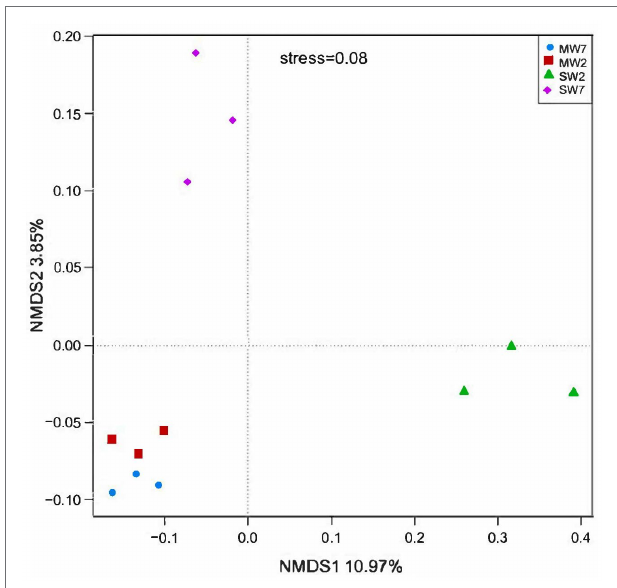
FIGURE 1 | The non-metric multidimensional scaling (NMDS) analysis of bacterial phylum among different rotation treatments. MW7, maize-wheat rotations for 7 years; MW2, maize-wheat rotations for 2 years; SW7, soybean- wheat rotations for 7 years; SW2, soybean-wheat rotations for 2 years; the same as